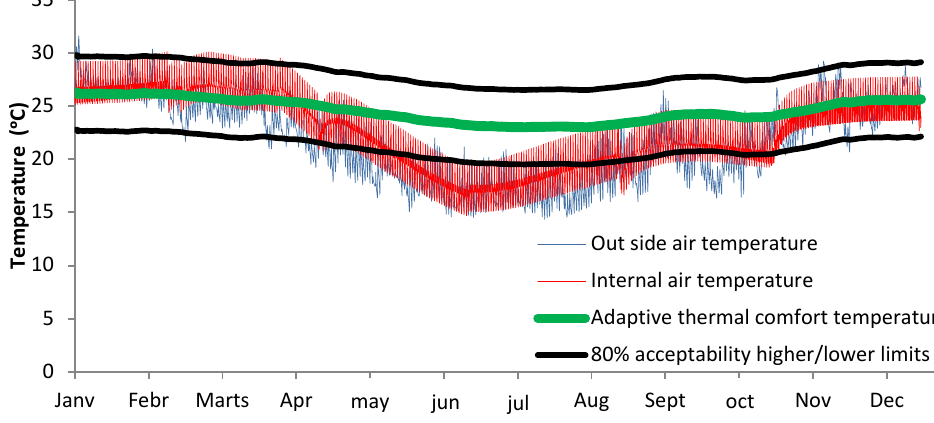
Fig. 7. Internal air temperatures and thermal comfort ranges for the InsBV module for one year using adaptive thermal range. The number of hours per year where the internal air temperatures of the buildings were outside of the 80 % acceptability limits for heating or cooling was estimated using the adaptive thermal comfort limits and shown in Fig. 8.